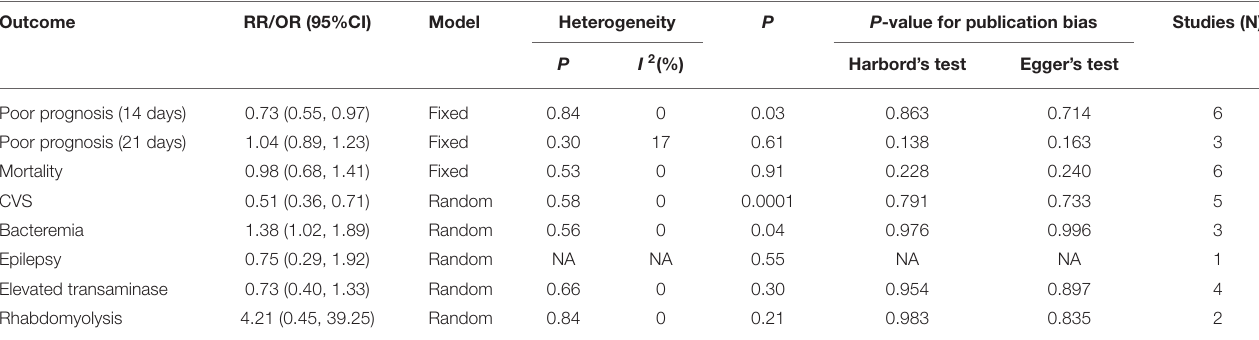
TABLE 3 | Meta-analysis of various outcomes and publication bias.